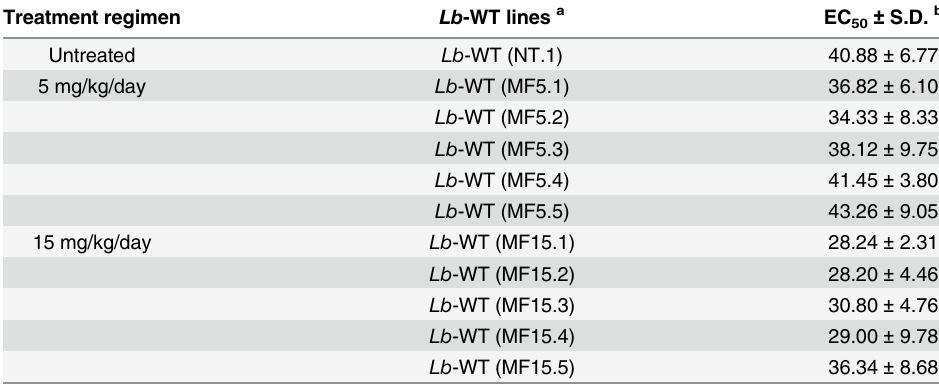
Table 2. Susceptibility of promastigotes to MF after recovery from BALB/c mice treated with 5 or 15